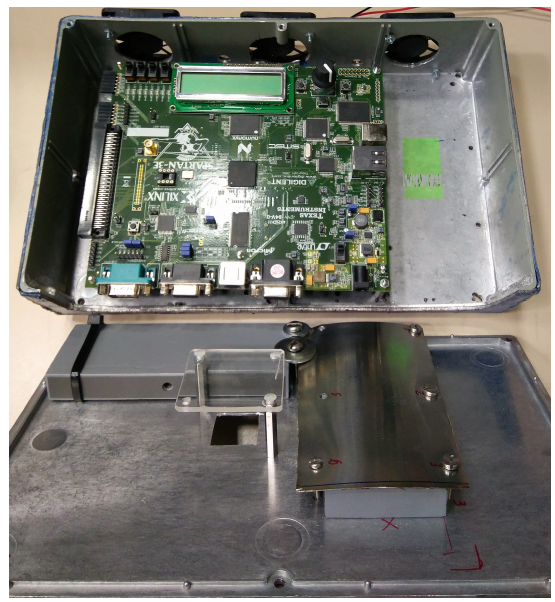
Figure 2. Shielding of the PCB attached to the cover of the filter box.